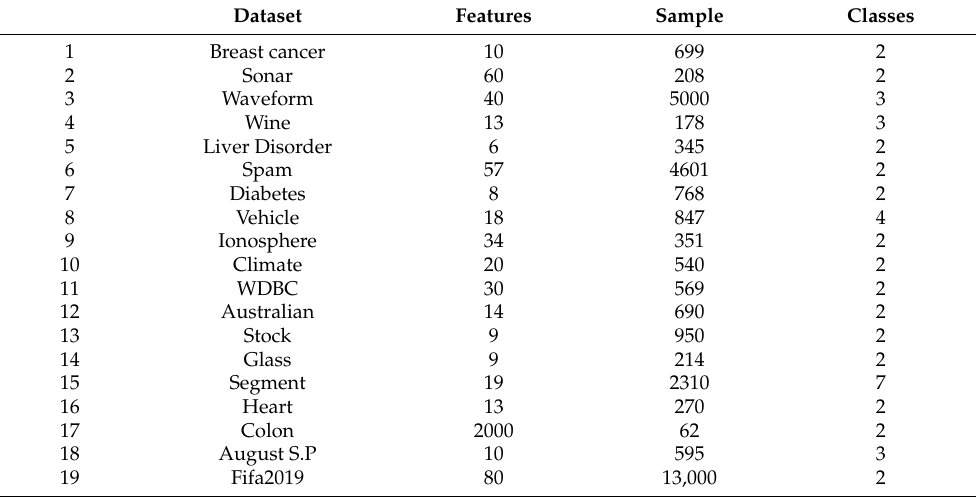
Table 2. Datasets used in this study.